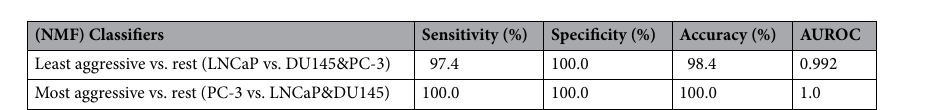
Table 2. Cross-validated sensitivity, specificity, accuracy and AUROC for LOOCV SVM using NMF.